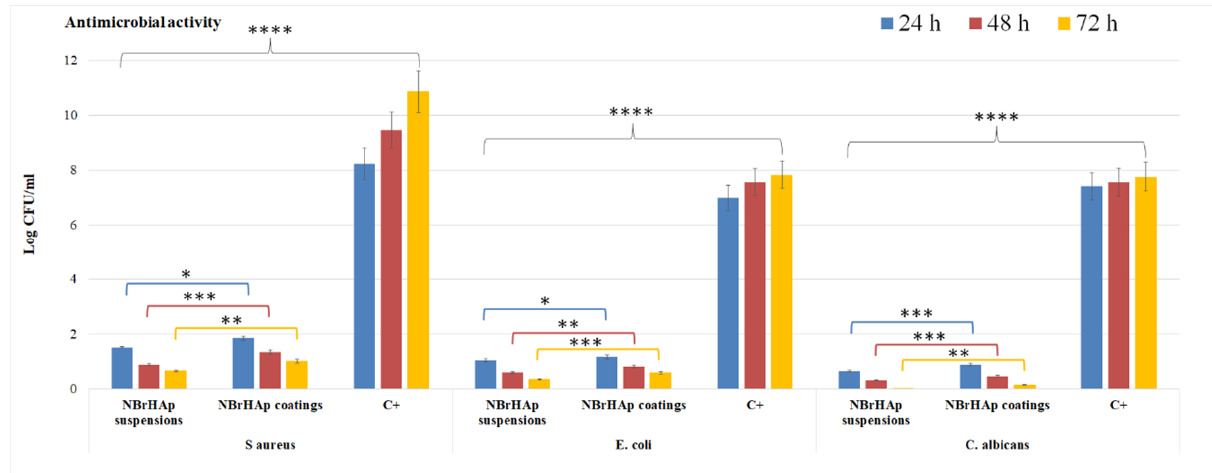
Figure 10. Graphic representation of the logarithmic values of colony forming units (CFU)/mL of S. aureus ATCC 25923, E. coli ATCC 25922, and C. albicans ATCC 10231 microbial strains after 24, 48 and 72 h of incubation with NBrHAp suspensions and coatings. The results are presented as means ± standard error of the mean of 3 independent experiments. Statistical analysis was performed by ordinary one-way ANOVA and Tukey multiple comparisons. The p -values indicated are * p ≤ 0.003, ** p ≤ 0.002, *** p ≤ 0.001, **** p ≤ 0.0001.